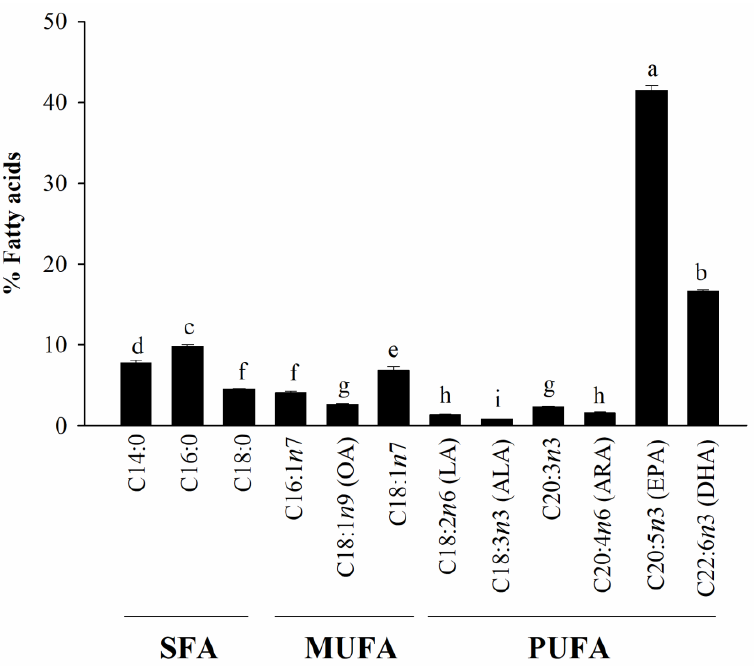
Figure 1. Fatty acid compositions of HAGF. Values are shown as means ± SD ( n = 5). Different letters (a–i) are used to reflect statistical differences at p <